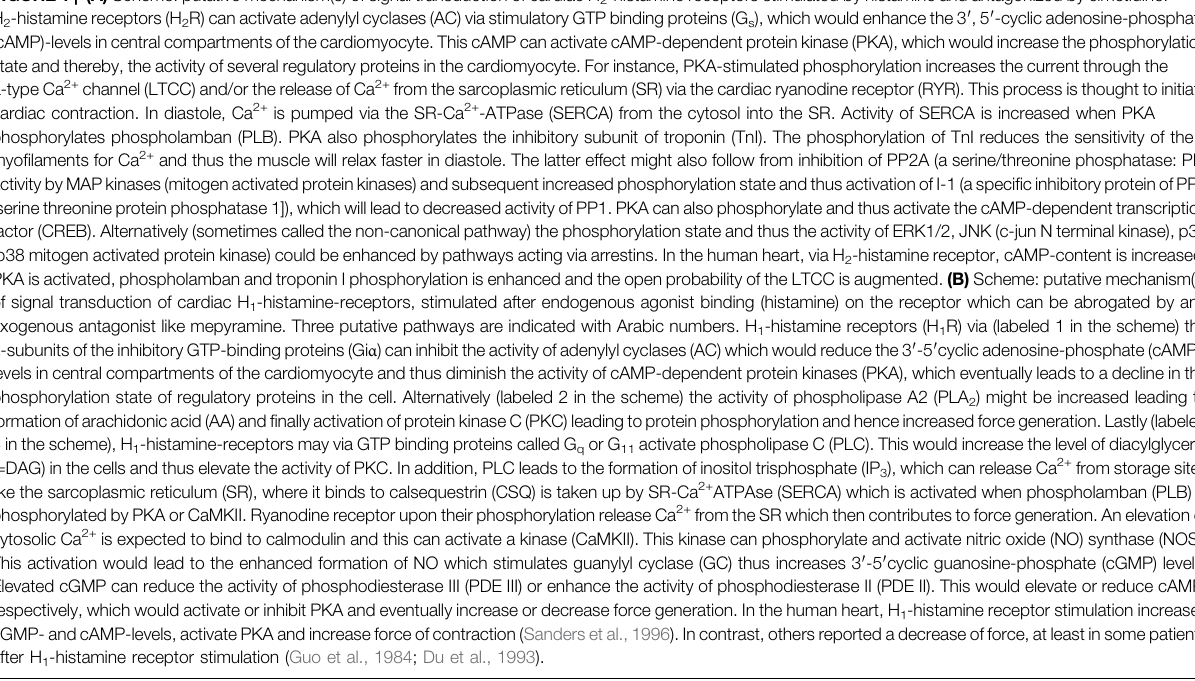
Frontiers in Pharmacology |